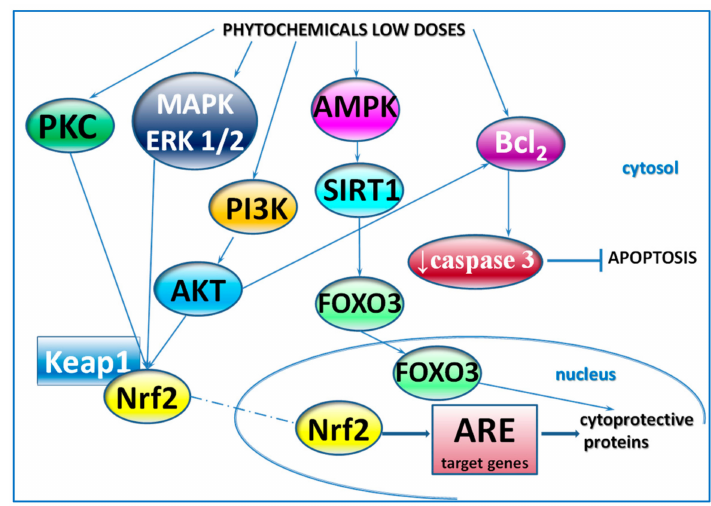
Figure 2. Examples of mechanisms involved in the cellular response to low doses of phytochemicals–on the basis of findings presented in the current review. Phytochemicals can activate kinase cascades, including PKC, MAPK / ERK1 / 2, PI3K / AKT, which play a critical role in the regulation of cell growth, proliferation, survival, and apoptosis. Downstream e ff ector of these kinases is transcription factor Nrf2, which is released from the complex with keap1 and translocates to the nucleus, binds to ARE and stimulates the expression of cytoprotective proteins, e.g., antioxidant enzymes and phase-2 proteins. SIRT-1 plays a key role in the cellular response to various stressors by activating transcription factor FOXO3, which induces genes encoding cytoprotective proteins. The transcriptional activity of FOXO3 is modulated by both AMPK and SIRT-1. PI3K / AKT is the major pathway mediating cell survival and inhibiting apoptosis. Bcl-2, a pro-survival, anti-apoptotic, and cytoprotective molecule, can